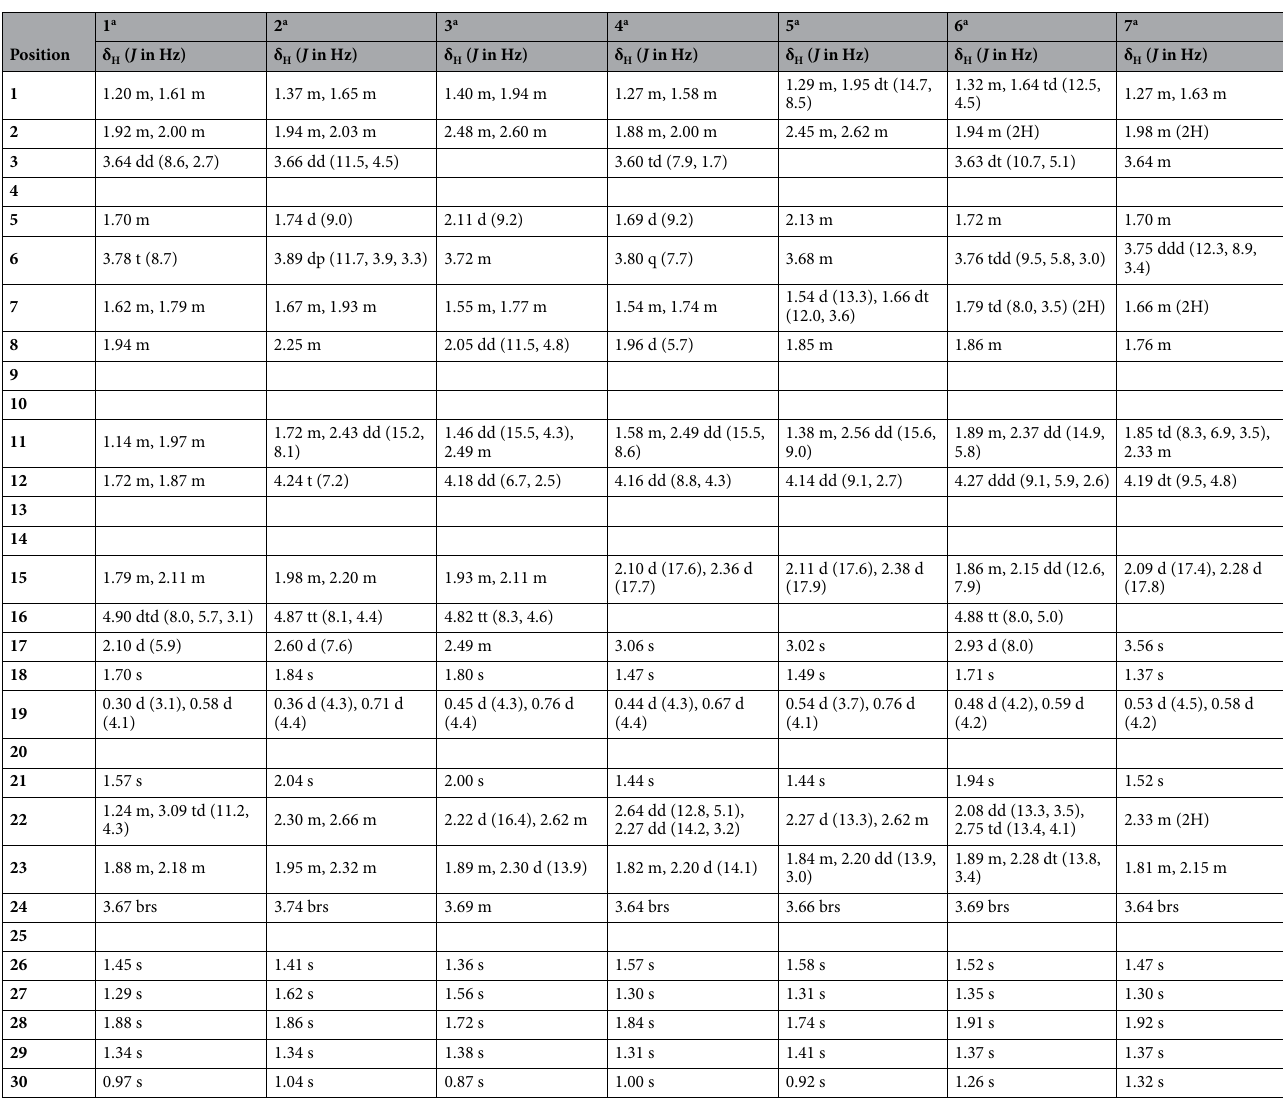
Table 2. 1 H NMR spectroscopic data of compounds 1 – 7 (400 MHz). a In C 5 D 5